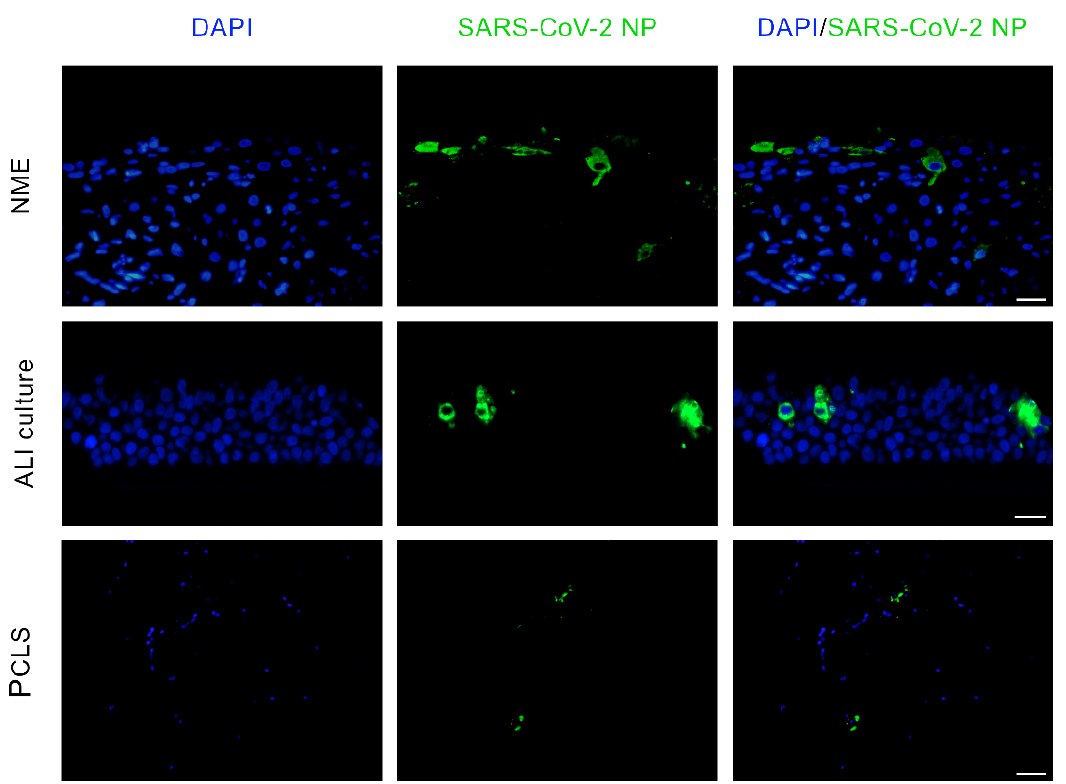
Figure 2. Immunofluorescence staining for SARS-CoV-2 NP in feline primary respiratory cell cultures. SARS-CoV-2 infected and uninfected nasal mucosa explants (NME, cat #2), air–liquid interface (ALI, cat #6) cultures derived from the trachea, and precision-cut lung slices (PCLS, cat #7) were stained for SARS-CoV-2 NP (green) with nuclear counterstaining (blue). Scale bar represents 20 µM.